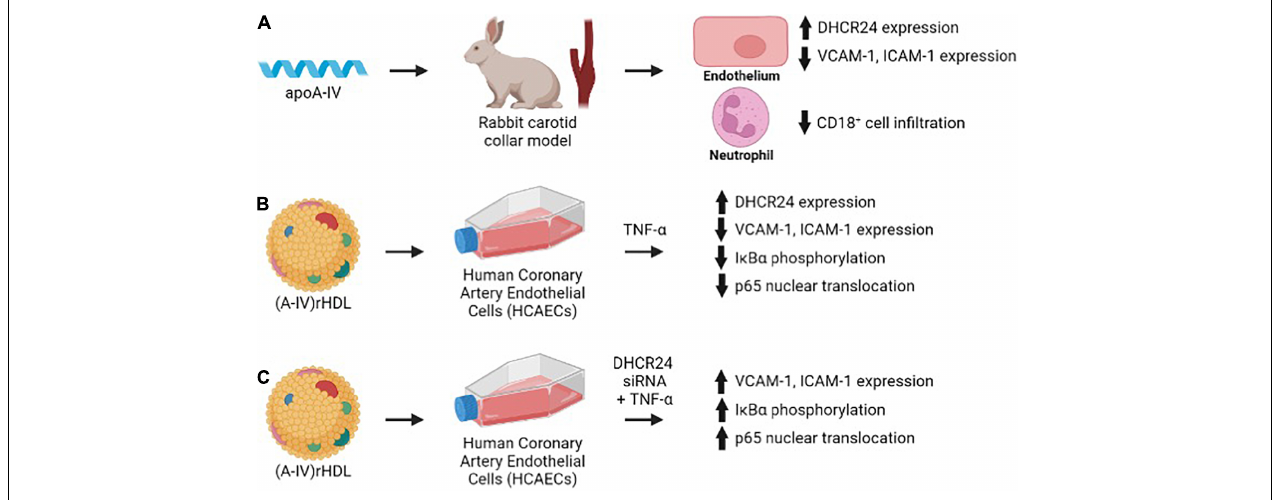
FIGURE 7 | Lipid-free and lipid-associated apoA-IV reduces acute vascular inflammation by inhibiting endothelial ICAM-1 and VCAM-1 expression (A,B) and NF- κ B activation in a DHCR24-dependent manner (C) .